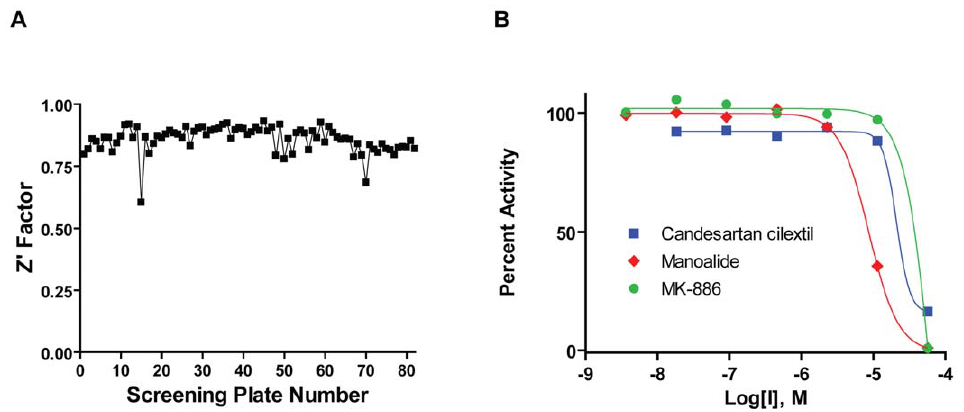
Figure 2. Summary of results from qHTS. ( A ) Excellent Z 9 factor of . 0.75 was maintained throughout the screen. ( B ) Concentration-response curves of top hits derived from the screen.